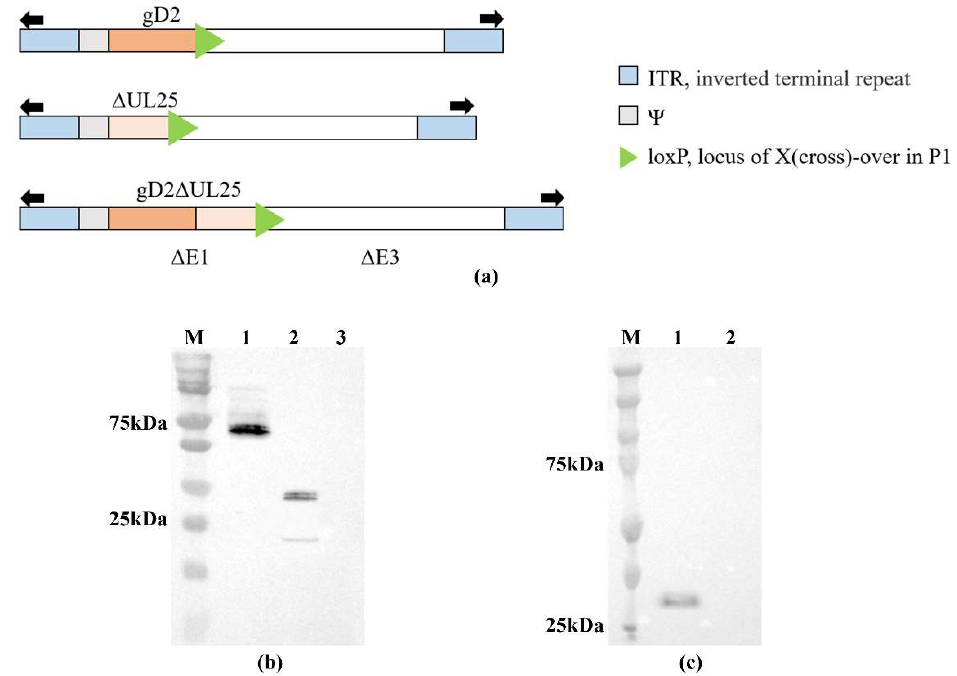
Figure 1. HEK293 cells were infected with recombinant adenoviruses or an empty adenovirus vector. Proteins produced from adenoviruses were assessed via Western blotting. ( a ) Schematic representation of recombinant adenoviruses. gD2, 1-306aa, ∆ UL25, 310-585aa. ( b ) Western blot analysis of rAd-gD2 ∆ UL25 (Lane 1), rAd-gD2 (Lane 2), and empty adenovirus vector (Lane 3) using gD2 rabbit polyclonal antibody. gD2 ∆ UL25 protein is approximately 67 kDa, and gD2 protein is approximately 36 kDa. ( c ) Western blot analysis of rAd- ∆ UL25 (Lane 1) and empty adenovirus vector (Lane 2) using anti-HA tag antibody. ∆ UL25 protein is approximately 32 kDa. M, Precision Plus Protein Dual Color